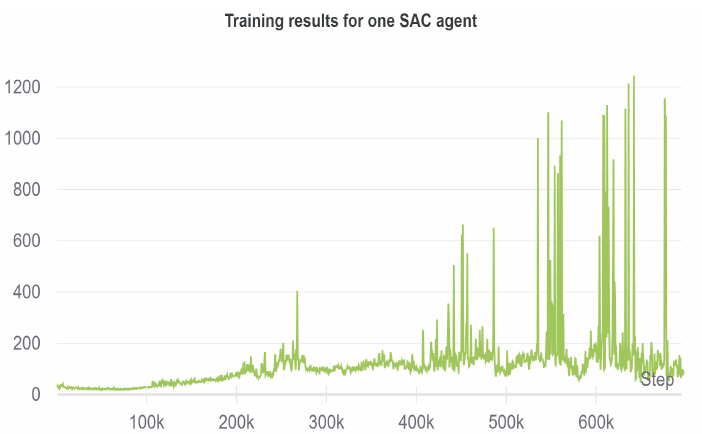
Figure 10. Progression of the accumulated reward for the decentralized single-agent SAC.